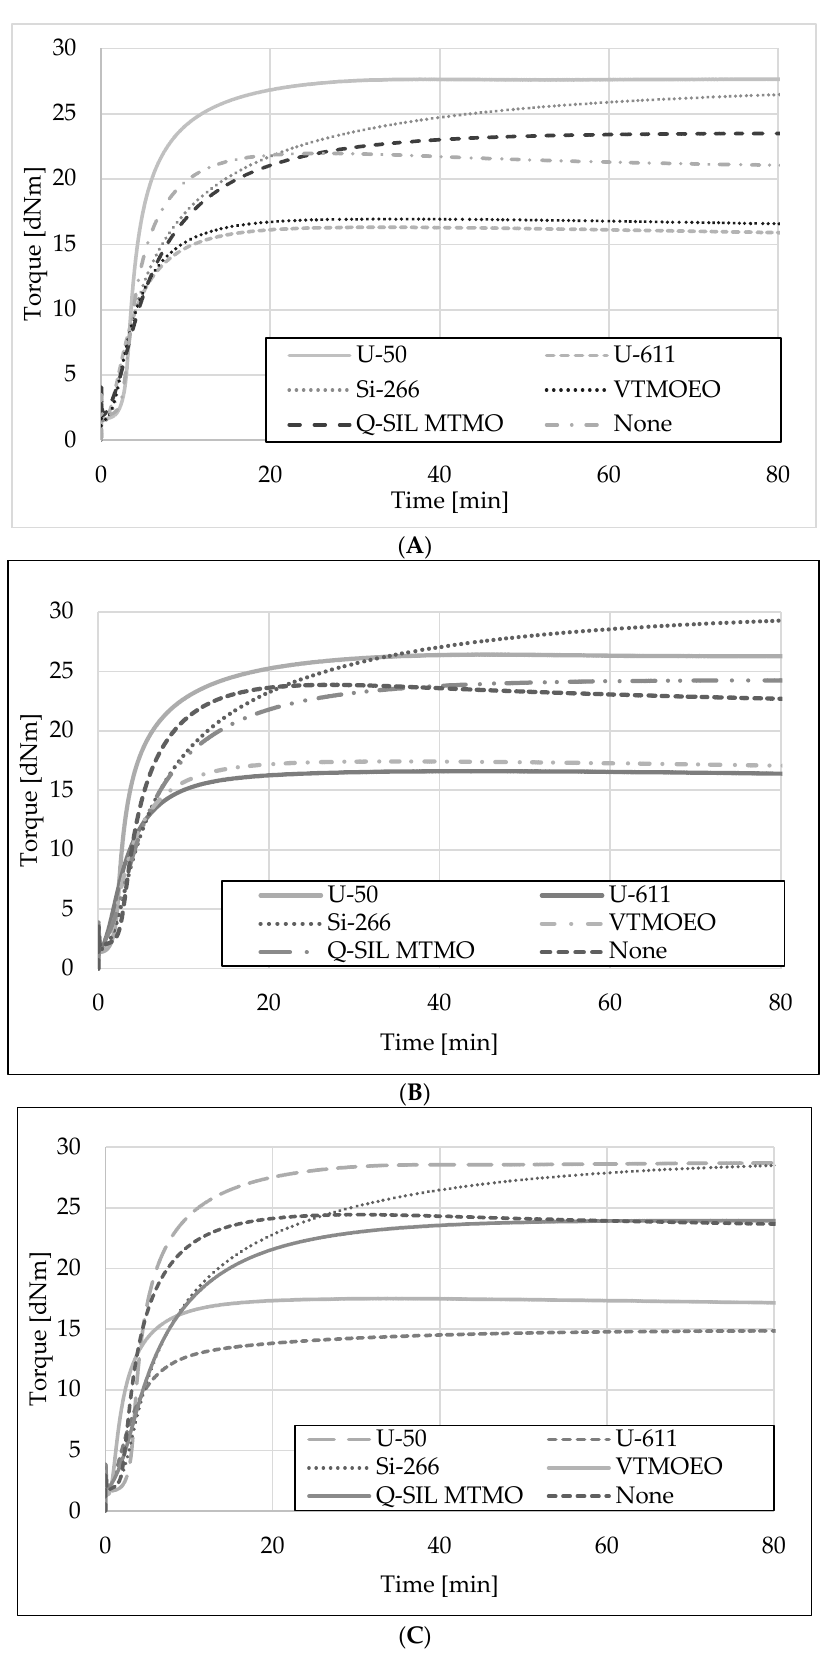
Figure 8. Vulcanization kinetics of the rubber compounds filled with 30 phr of N-220 and 20 phr of unmodified or silanized: ( A ) FA-63; ( B ) FA-125; ( C )